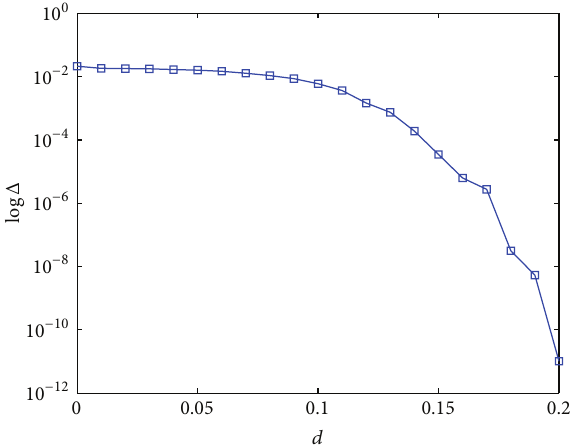
Figure 2: The evolution of Δ with respect to 𝑑 in three coupled R¨ossler like systems, when 𝑐 = 0.045 , 𝑇 0 = 4×10 3 , and 𝑇 1 = 5×10 3 .